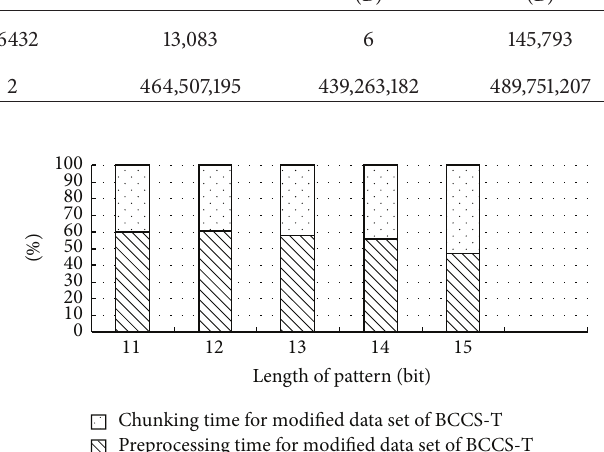
Figure 10: Ratio of chunking time and preprocessing time for modified data set of BCCS-T.